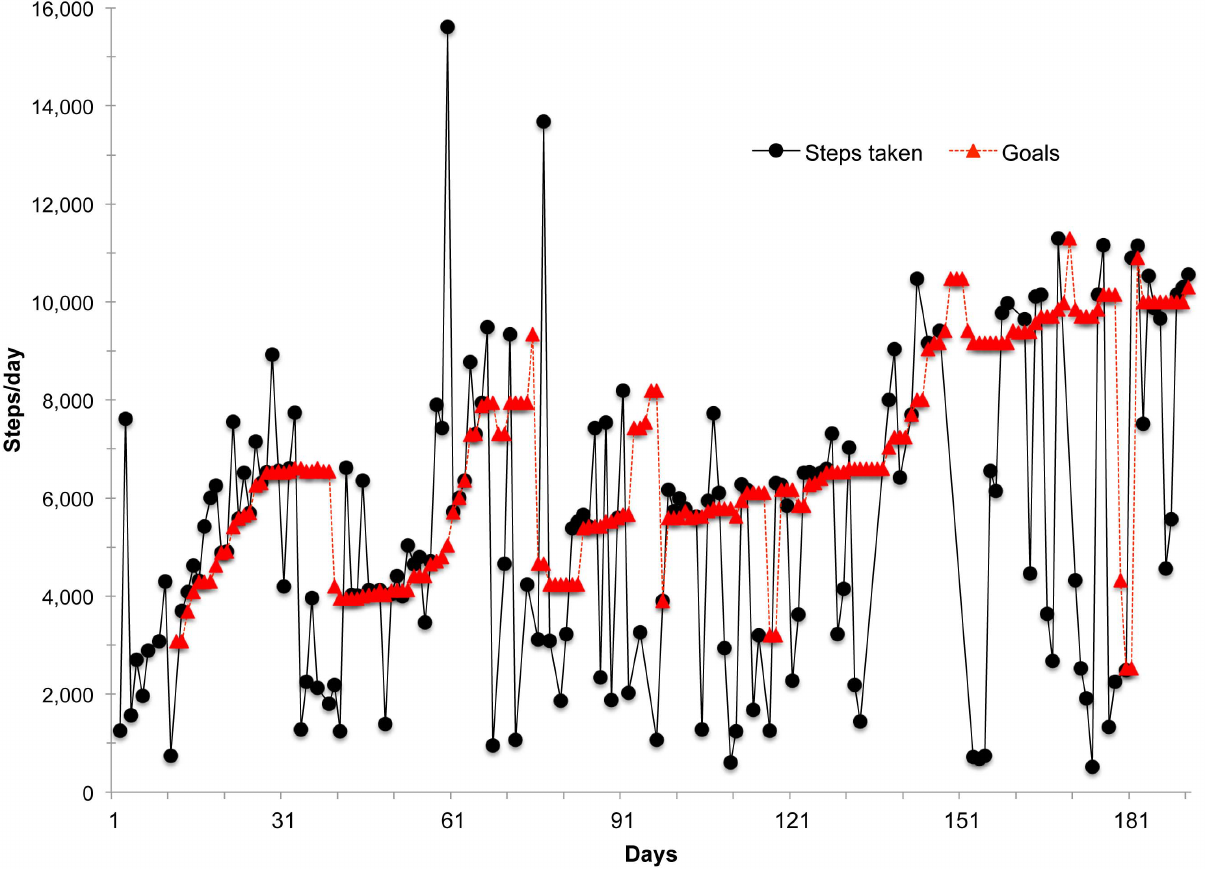
Figure 1. Example of actual steps/day and percentile-based goals over 6 months for a single participant. Figure shows how adaptive goals adjust up and down based on prior performance.